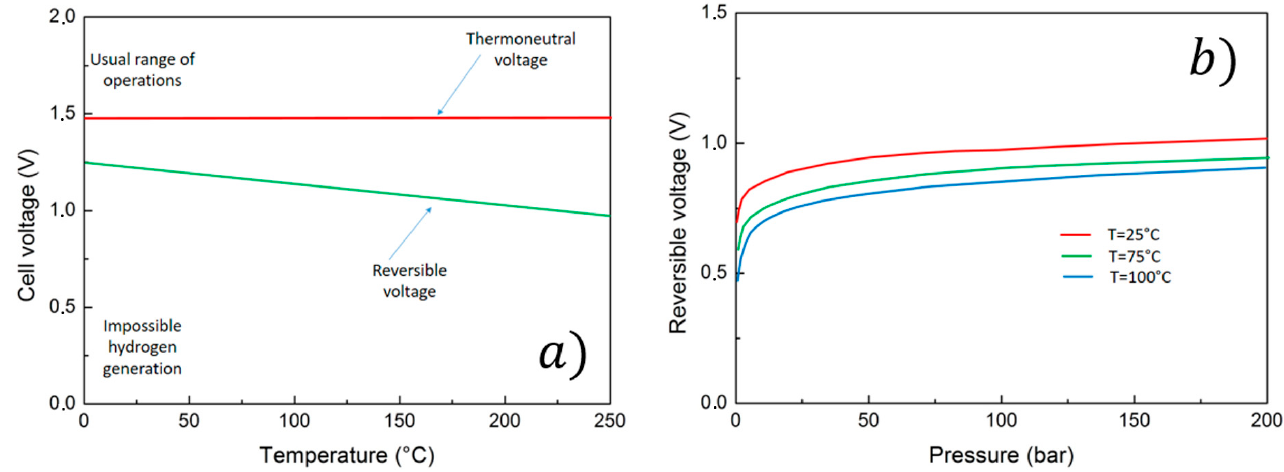
Figure 6. ( a ) Reversible and thermoneutral voltages as a function of cell temperature; ( b ) Reversible voltage as a function of pressure for different cell temperatures.